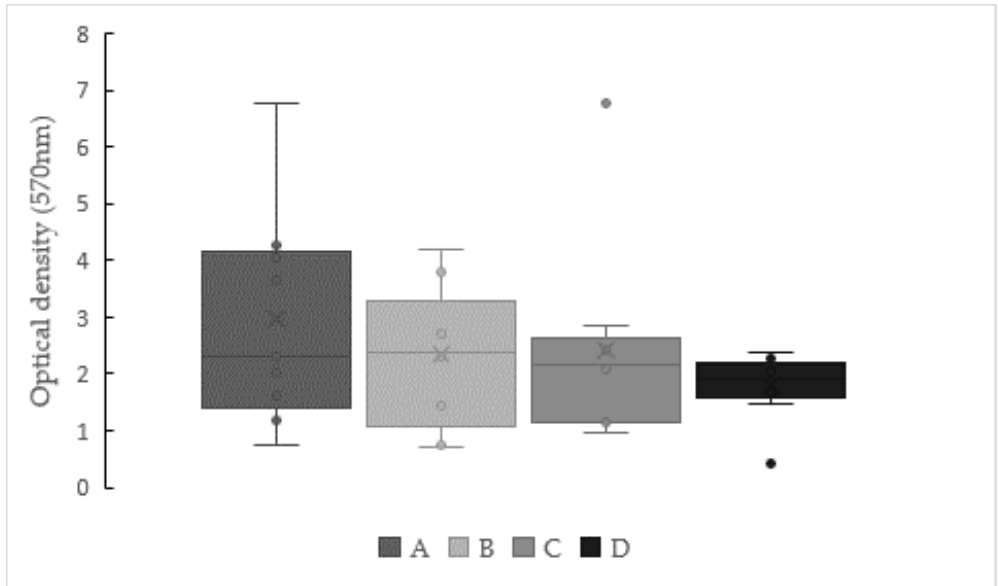
Figure 2. Biofilm production by mixed cultures observed after growth in BHI with mucin at 37 °C for 48 h. Legend: A— Streptococcus mutans + S. oralis + S. sanguinis + S. salivarius ; B— Streptococcus mutans + S. oralis + S. sanguinis + S. salivarius + Actinomyces viscosus ; C— Streptococcus mutans + S. oralis + S. sanguinis + S. salivarius + Enterococcus faecalis (OG1-10) and D— Streptococcus mutans + S. oralis + S. sanguinis + S. salivarius + Actinomyces viscosus + Enterococcus faecalis (OG1-10, DS16 and V583). No significant difference based on the Kruskal-Wallis test ( p < 0.05). The lower and upper limits of the box are the first and third quartiles, respectively, median (central horizontal bar), mean (cross) and whiskers’ upper and lower bounds (vertical lines), and outliers (point) are values that fall outside of the adjacent value